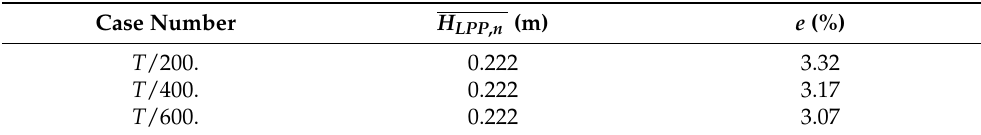
Table 6. Wave propagation errors due to temporal discretization for case 3.